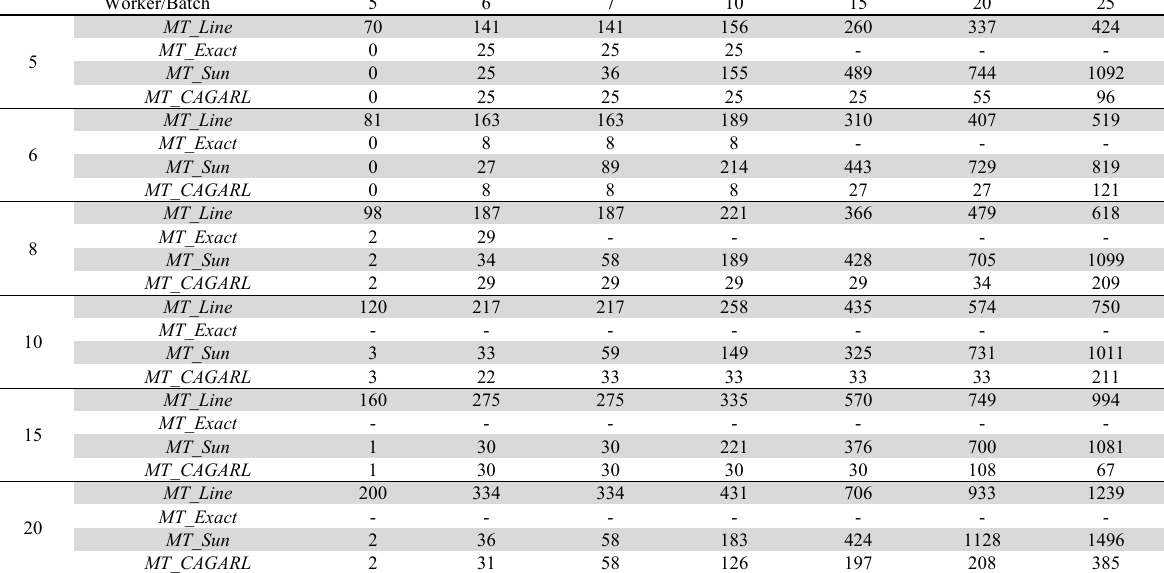
Table 4 Solution of the assembly line, exact algorithm, comparison algorithm, and CAGARL